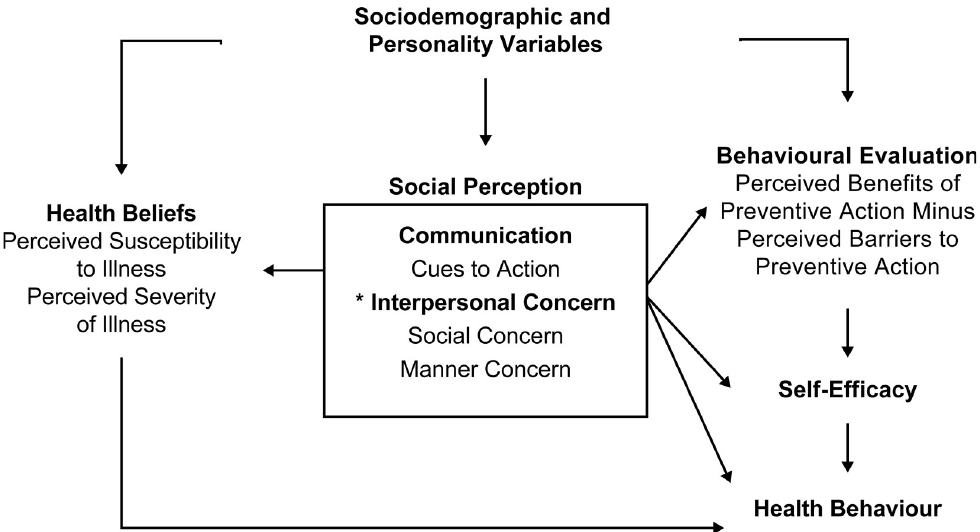
Fig 1. The hypothesized model based on the reconfigured health belief model developed by Mattson [16]. Asterisk ( � ) indicates newly introduced constructs for the study.